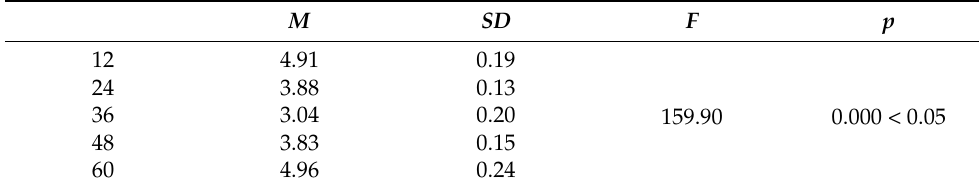
Figure 12. Response time of each speed target under intensity 142 stimulation. Table 6. Time statistic value under intensity 142.